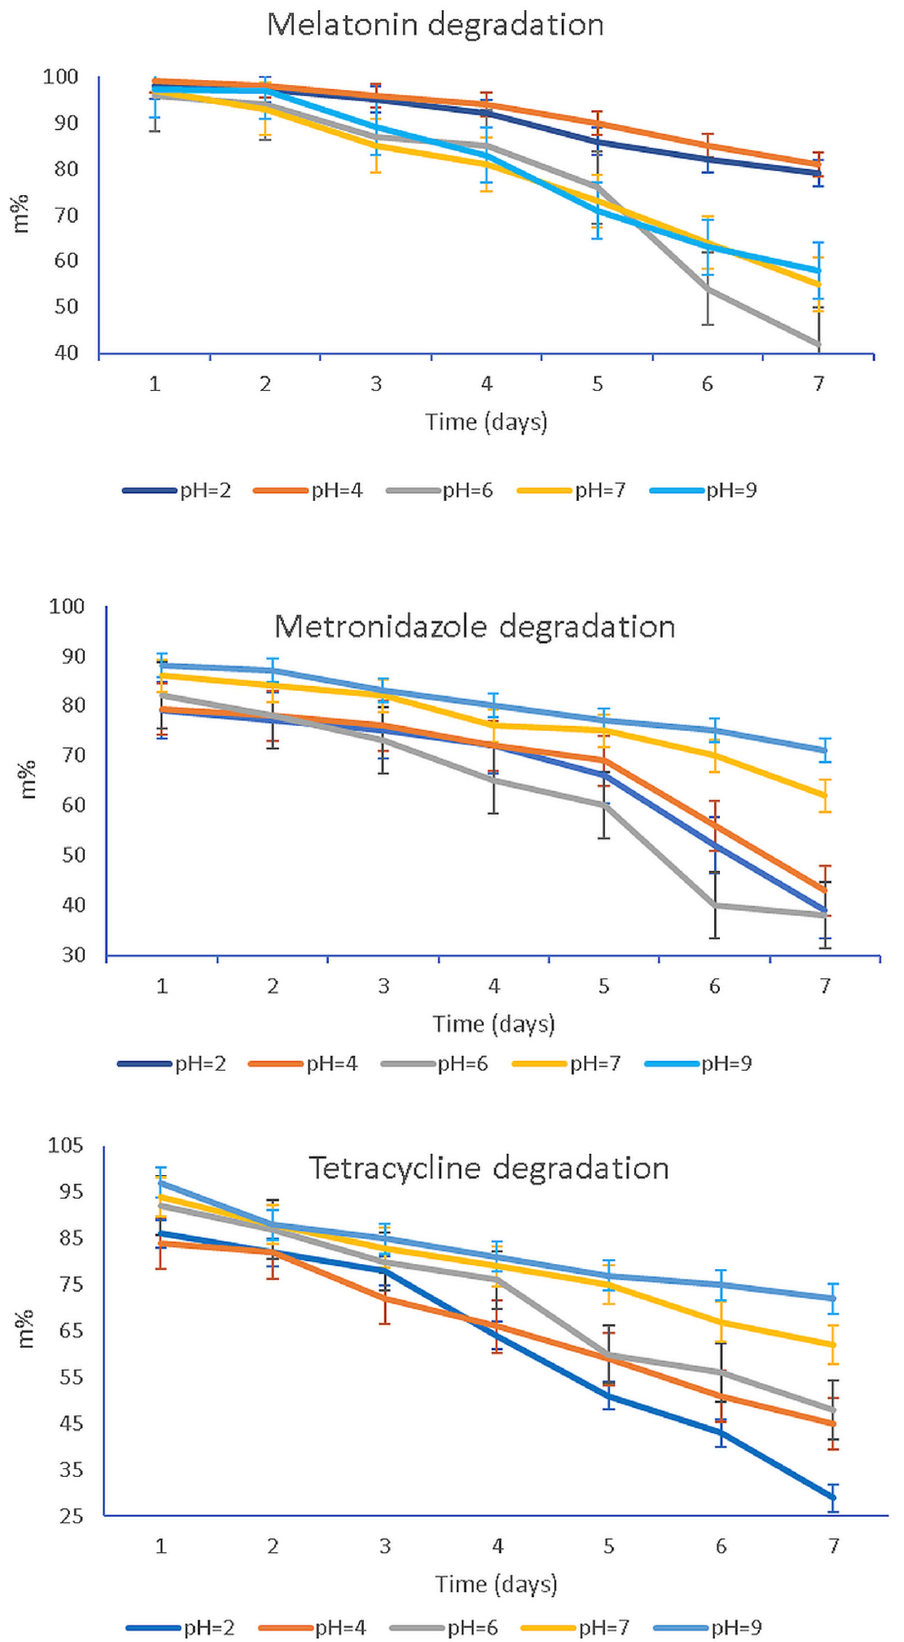
Figure 8. Degradation of the bioactive compounds MEL, MZ, and T as a function of pH values throughout the storage time of 7 days, at 25 ◦